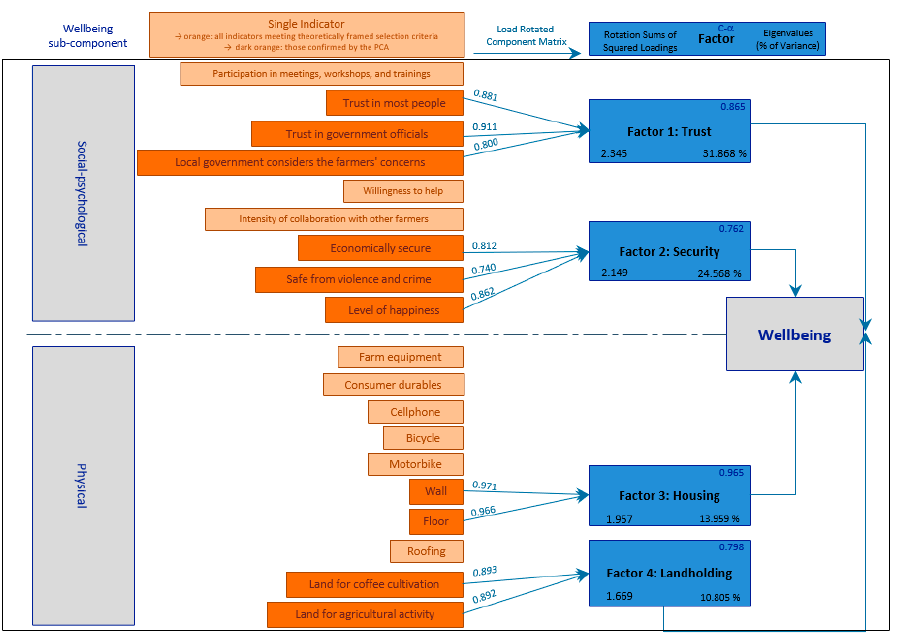
Figure 2. Summarizing the components of wellbeing, the indicators investigated, and the results ofthe principal component analysis